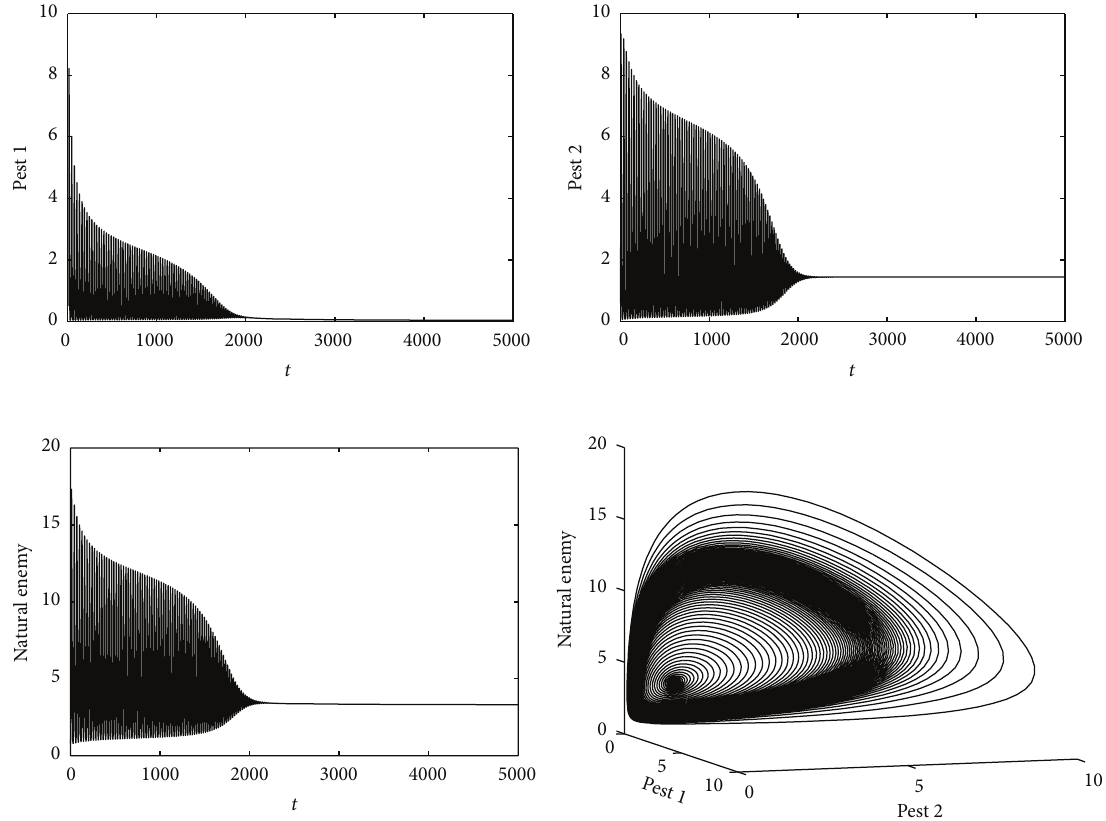
Figure 2: Time series and phase portrait of system (1) with 𝛼 1 = 0.6000 and other parameters the same as Figure